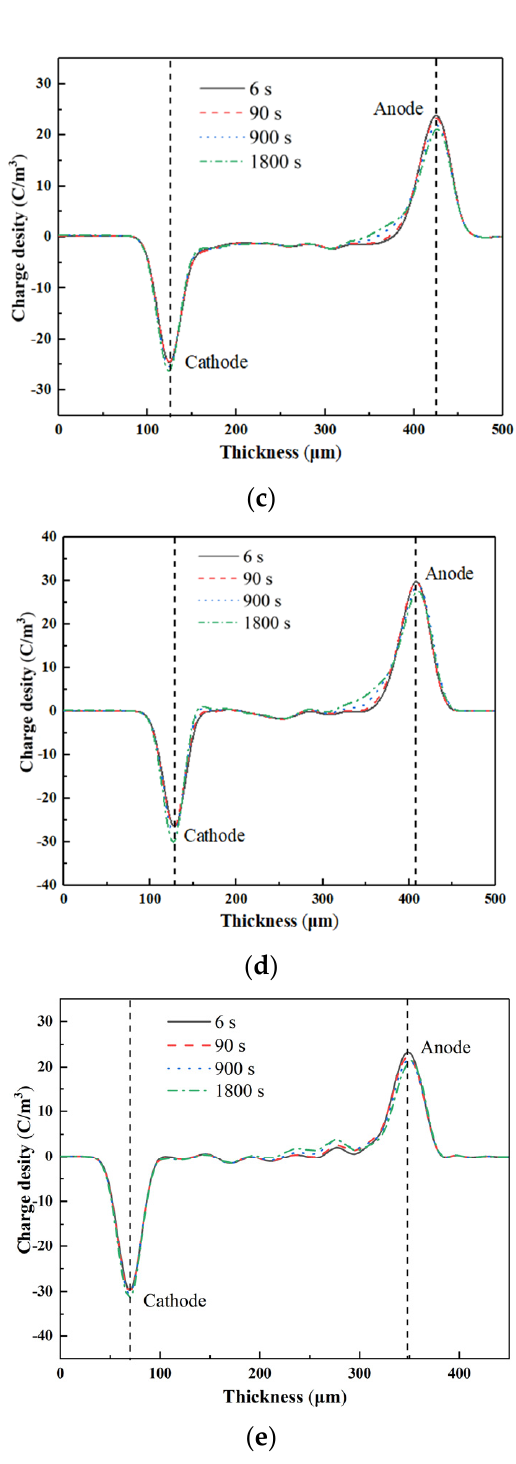
Figure 7. Space-charge distribution of pure LDPE and nanocomposite specimens with different content of Al 2 O 3 -h-BN/LDPE under 40 kV/mm polarization field: ( a ) LDPE; ( b ) 1% (0.5%h-BN/0.5%Al 2 O 3 )/LDPE; ( c ) 2% (1.0%h-BN/1.0%Al 2 O 3 )/LDPE; ( d ) 4% (2.0%h-BN/2.0%Al 2 O 3 )/LDPE; and ( e ) 7% (3.5%h-BN/3.5%Al 2 O 3 )/LDPE.